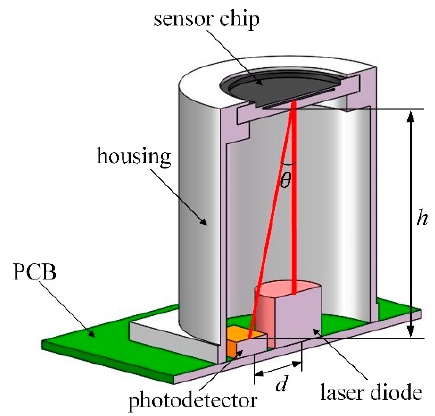
Figure 5. Schematic diagram of the packaged acoustic sensor.